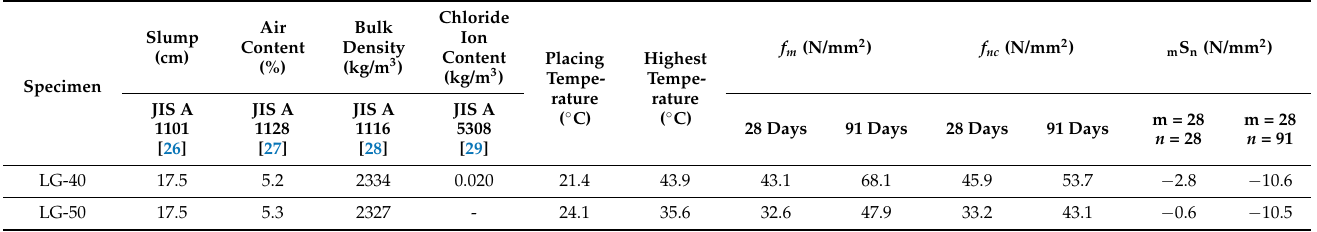
Table 7. Calculation results of S value in the standard period in the case of